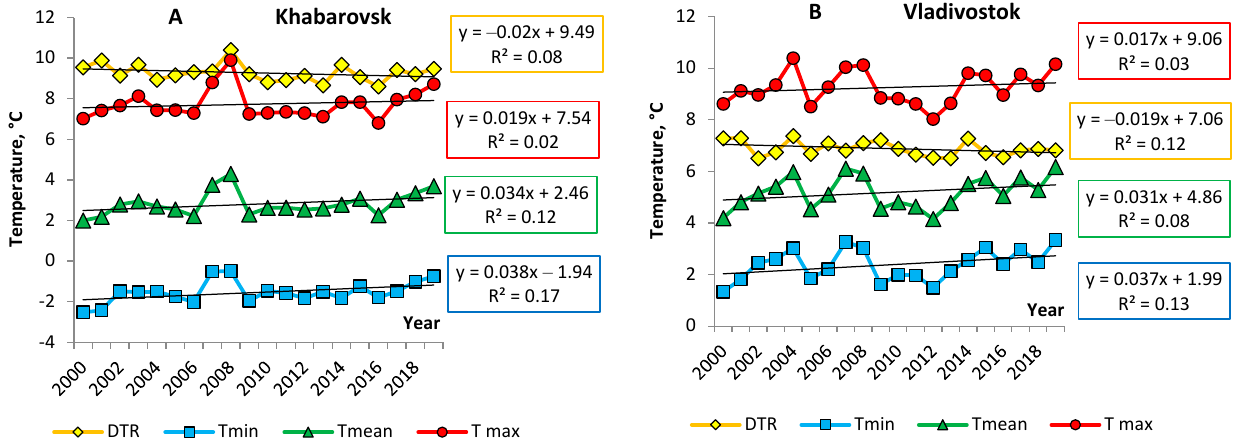
Figure 7. Temporal dynamics of minimum, mean, maximum air temperatures, and DTR, in capital cities of the RFE: Khabarovsk ( A ) and Vladivostok ( B ), during the study period from 2000 to 2019. Black solid lines show the linear trend of the correspondent series.